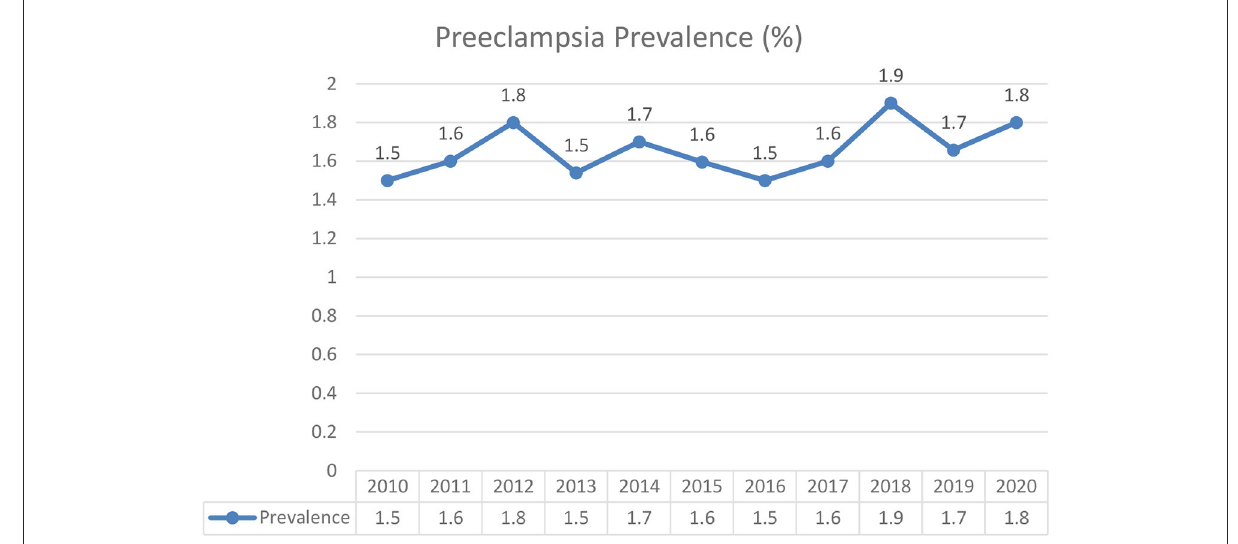
FIGURE1 Prevalence of preeclampsia from 2010 to 2020 in Hospital Chancellor Tengku Mukhriz (HCTM).